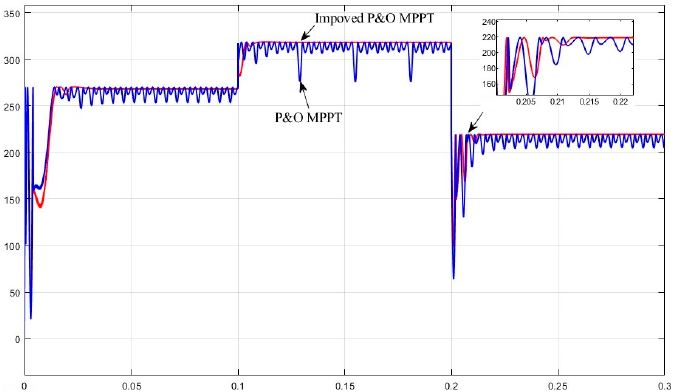
J. Mar. Sci. Eng. 2023 , 11 , 222 Figure 18. Power generation of P&O MPPT and improved P&O MPPT. Figure 18. Power generation of P&O MPPT and improved P&O MPPT.